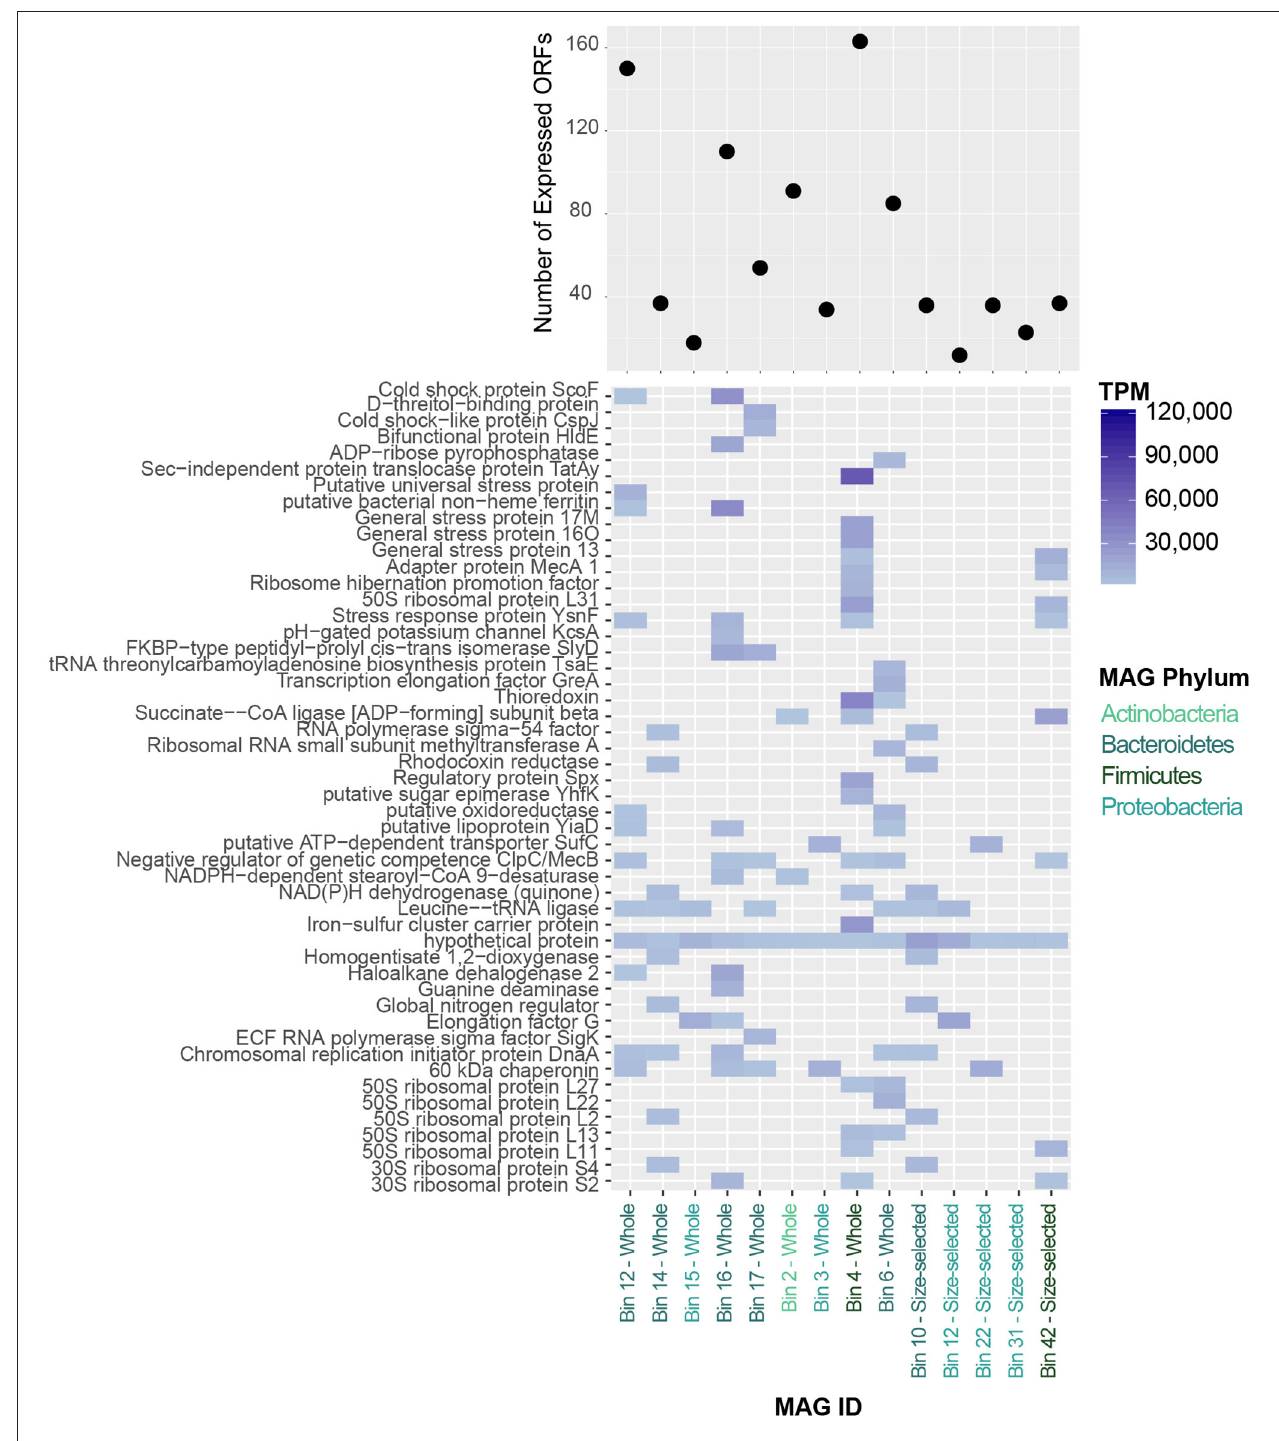
FIGURE 9 | (Top) Number of expressed protein-coding genes in Lake Vanda MAGs. (Bottom) Heatmap of the 50 most highly-expressed protein-coding genes in Lake Vanda MAGs. MAG identities are color-coded according to Phylum-level taxonomy.